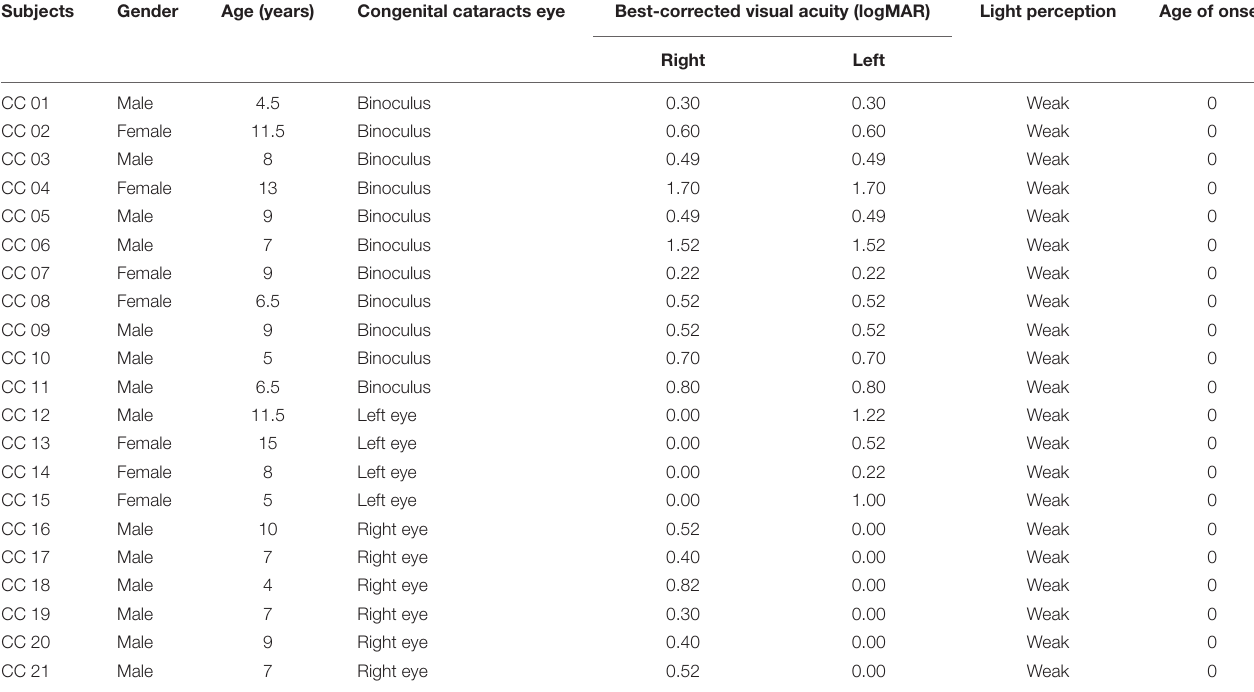
TABLE 2 | Demographic information of congenital cataracts subjects. Subjects Congenital cataracts eye Best-corrected visual acuity (logMAR) Light perception Age of onset